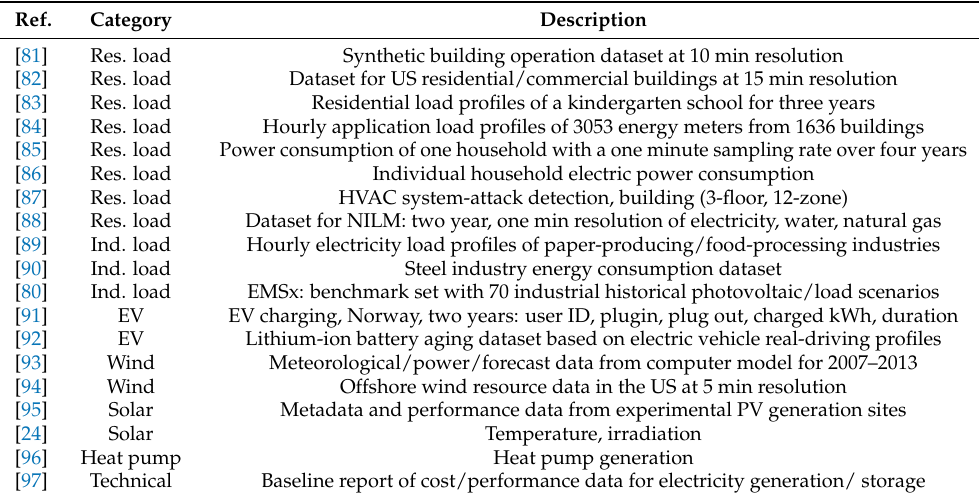
Table 5. Open available historical datasets for energy management systems.